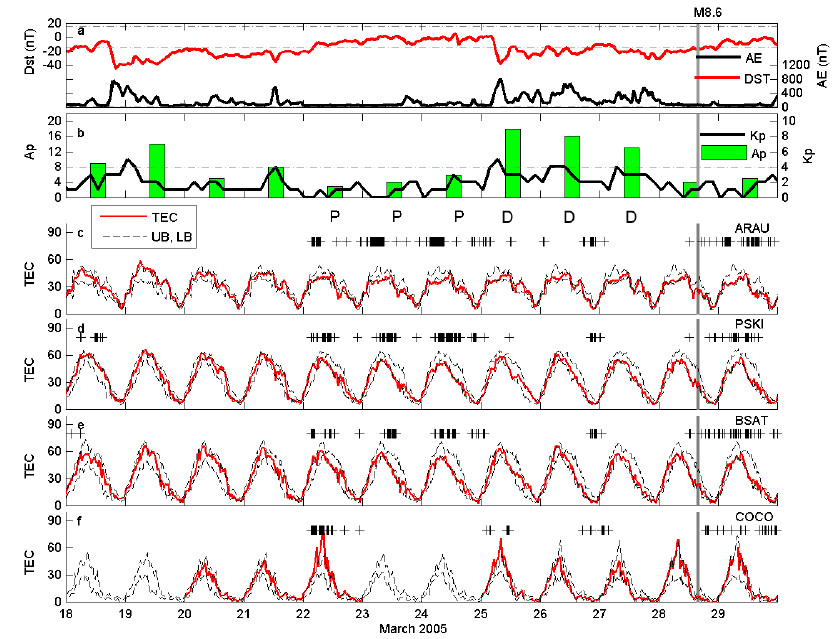
Fig. 5. The geomagnetic indices (a) Dst and AE, (b) Ap and Kp, and the (c-f) TEC variations and the associated upper and lower bounds between 18 and 29 March 2005 at 4 GPS stations.